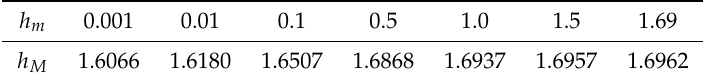
Figure 3. The trajectories of states x 1 and x 2 of (18) with constant sampling 1.6962. Table 3. Maximum bounds of h M for different h m by Proposition